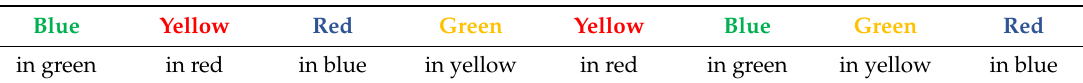
Table 3. Stimuli 2 in